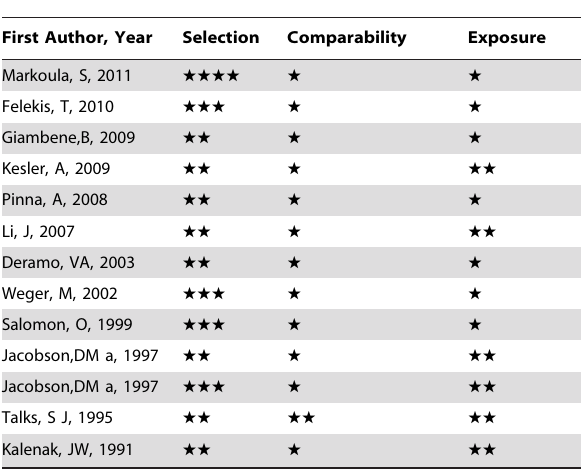
Table 2. Assessment of study